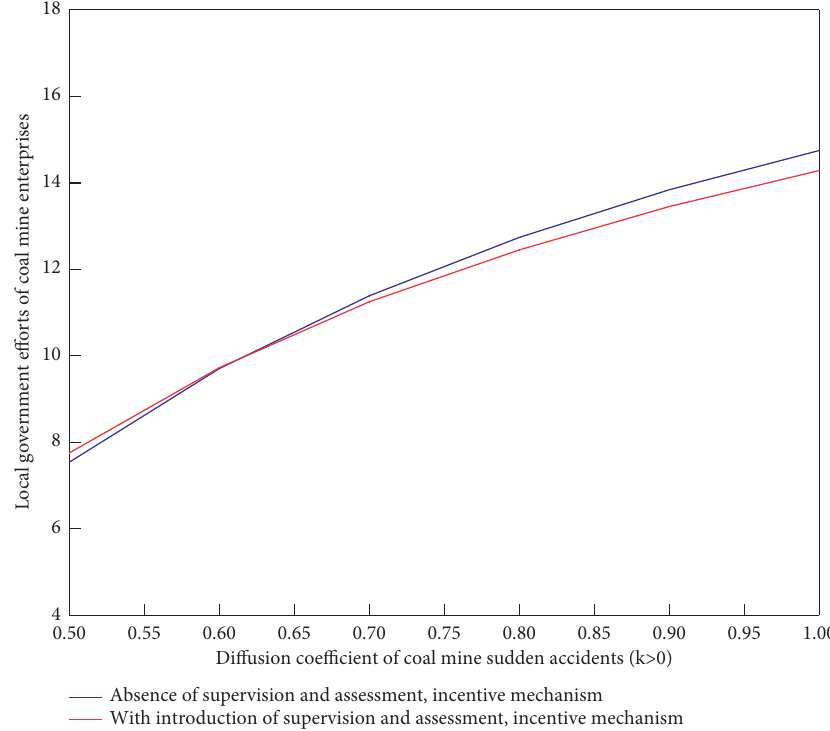
Figure 5: Relationship between the emergency effort of the local government and the diffusion trend of a sudden coal mine disaster (k ＞